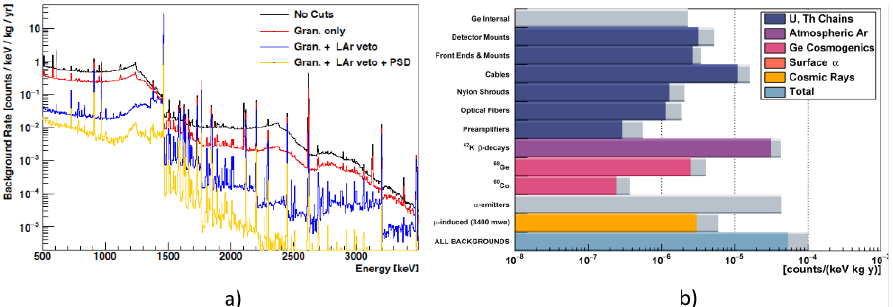
Figure 15. ( a ) Reduction of the γ rate due to the 238 U, 232 Th and 40 K chains. Figure published by J. Phys. Conf. Ser., 2020 [110]. ( b ) Projected contribution of the different sources to the overall total background. Grey bars indicate 1 σ uncertainties of the background contributions due to screening measurements and Monte Carlo simulations. A total background of 1 anticipated. Figure published by J. Phys. Conf. Ser., 2020